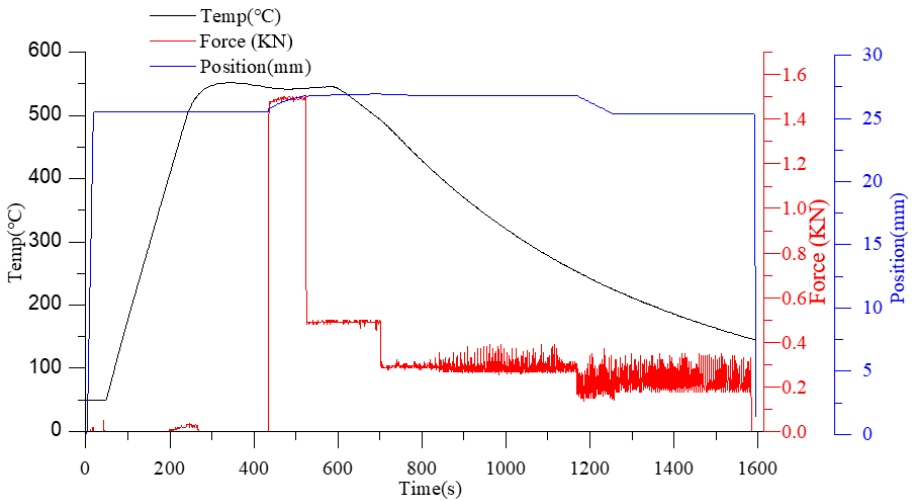
Figure 7. Process parameters for glass molding.